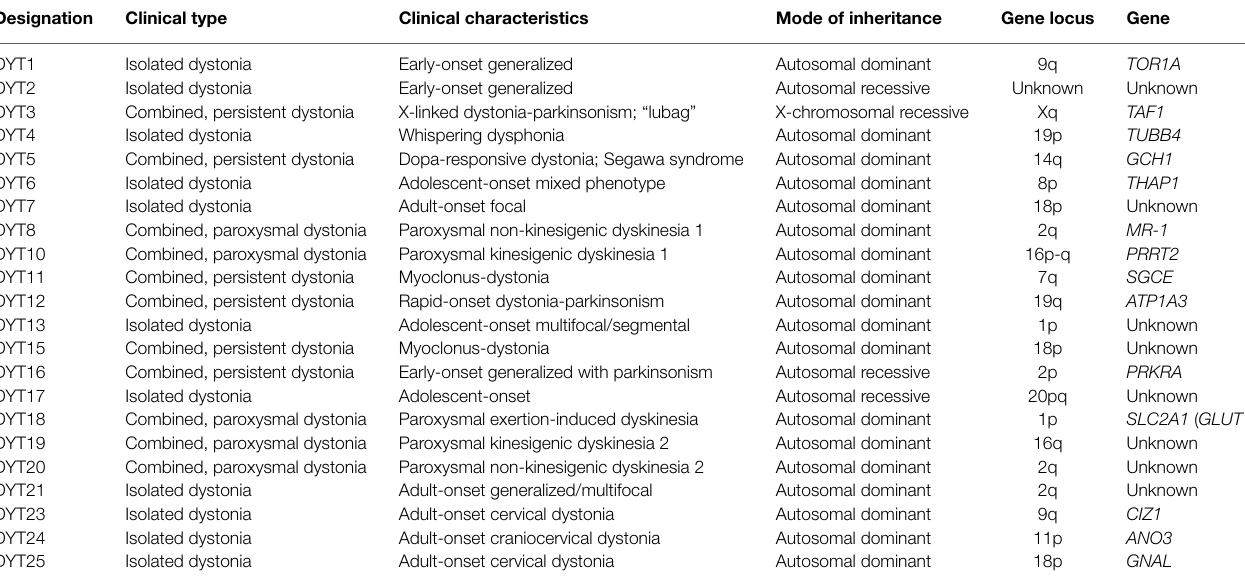
TABLE 4 | Etiology of inherited dystonia in humans (38, 39, 37)